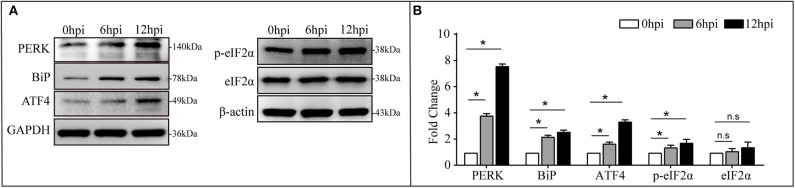
Expression of BiP (GRP78), PERK, eIF2α/p-eIF2α, and ATF4 was increased in B. pseudomallei-infected A549 cells. (A) Western blot analysis of DEGs involved in UPR challenged with B. pseudomallei. GAPDH and β-actin were used as loading controls, and all experiments were performed three times. (B) The relative expression level of DEGs in every group. Cells without infection (0 hpi) was the control group. A t-test was performed to compare the means, and the asterisks represent the P-value as follows * <0.05, n.s = non-significant, and P-value > 0.05 is considered not statistically significant.